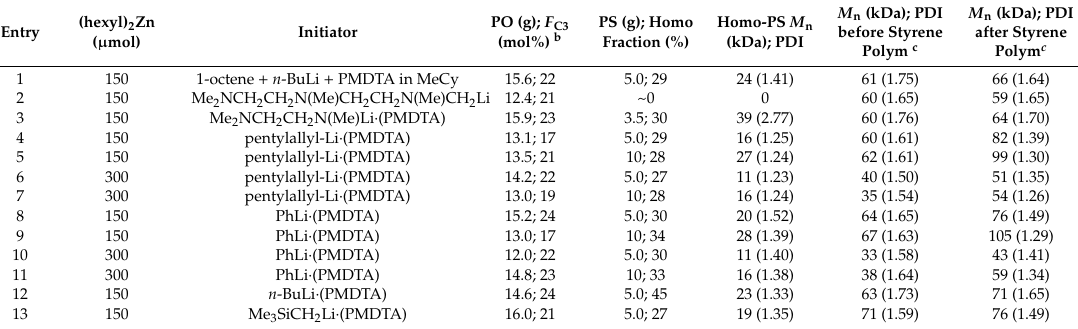
Table 3. Results for preparation of poly(ethylene- co -propylene)- b -PS a .